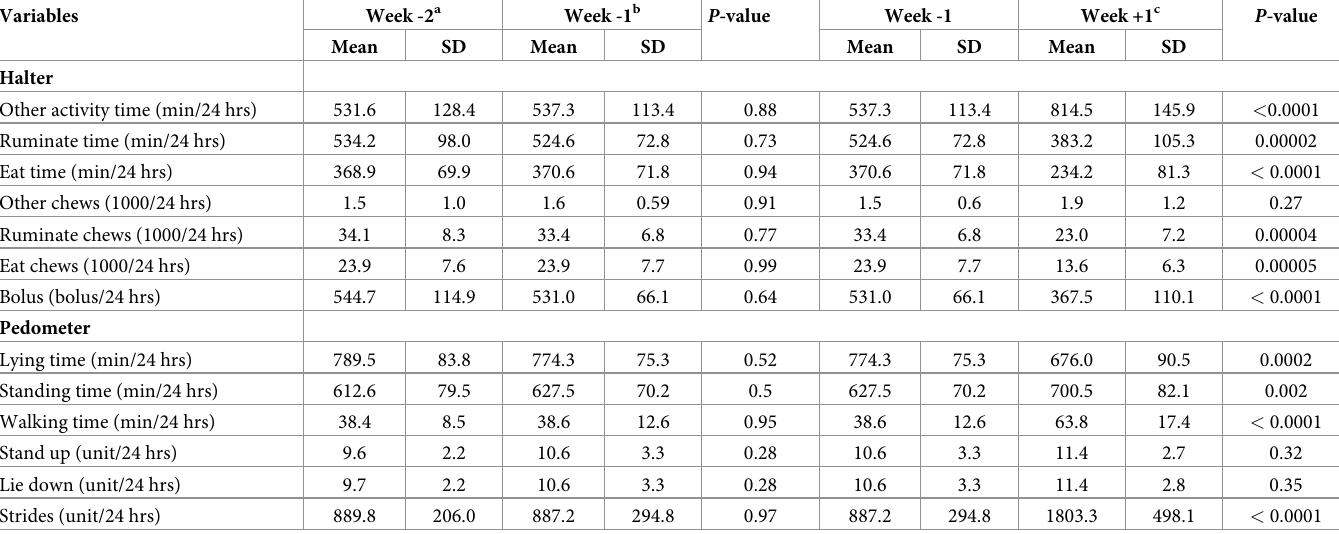
Table 2b. Mean values of variables of RumiWatch 1 halters and pedometers group-S cows (sick cows) at week -2, -1 and